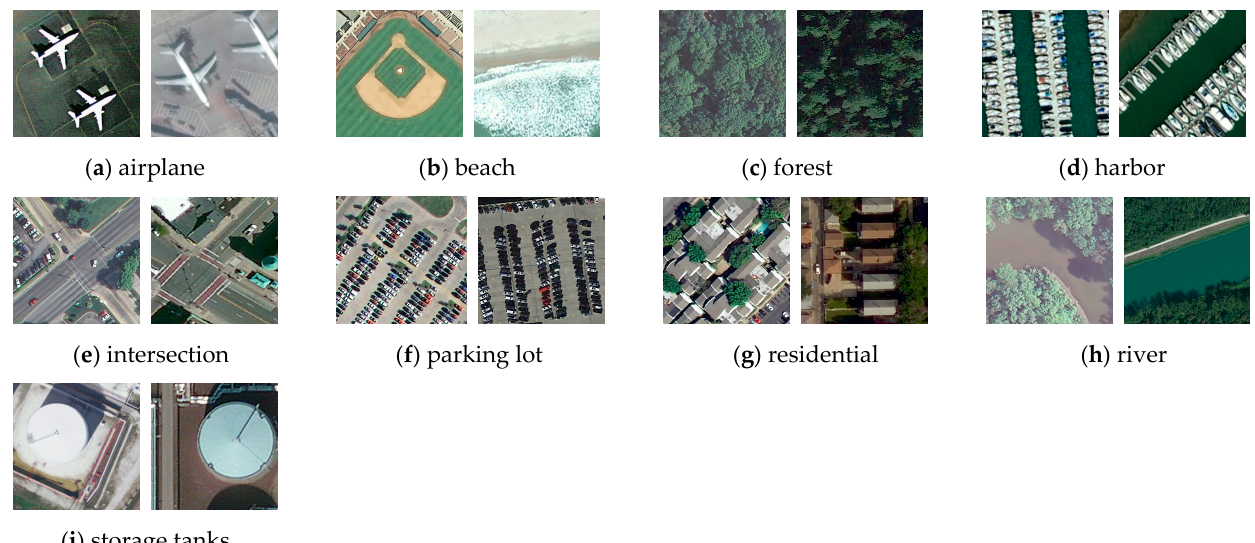
Figure 8. Samples of each common class for UC Merced (UCM) ( left ) and NWPU-RESISC45 (NWPU) ( right ).